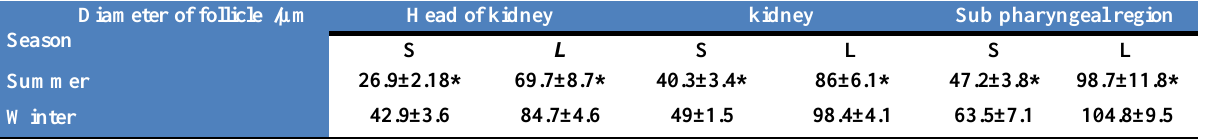
Table, 1: The diameter of thyroid follicles (µm) carp fish in the two seasons.